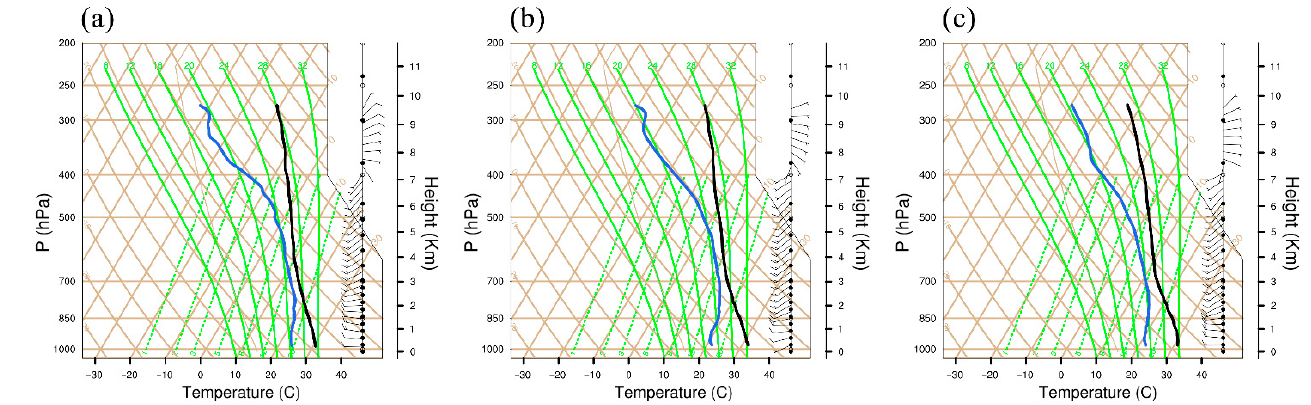
Figure 8. Skew − T diagrams of the initial temperature (black line), dew point temperature (blue line), and wind field (right-hand line) profiles used in this study: ( a ) Chang’an district, ( b ) Weiyang district, and ( c ) Gaoling district.